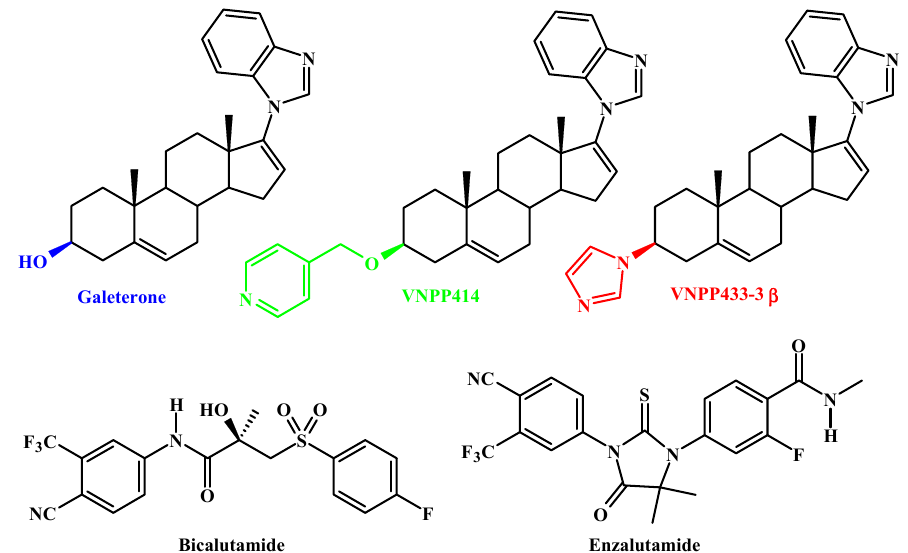
Figure 1. ChemicalstructuresofGaleterone, VNPP414andVNPP433-3 β , Bicalutamide, Figure 1. Chemical structures of Galeterone, VNPP414 and VNPP433-3 β , Bicalutamide, and Enzalutamide.